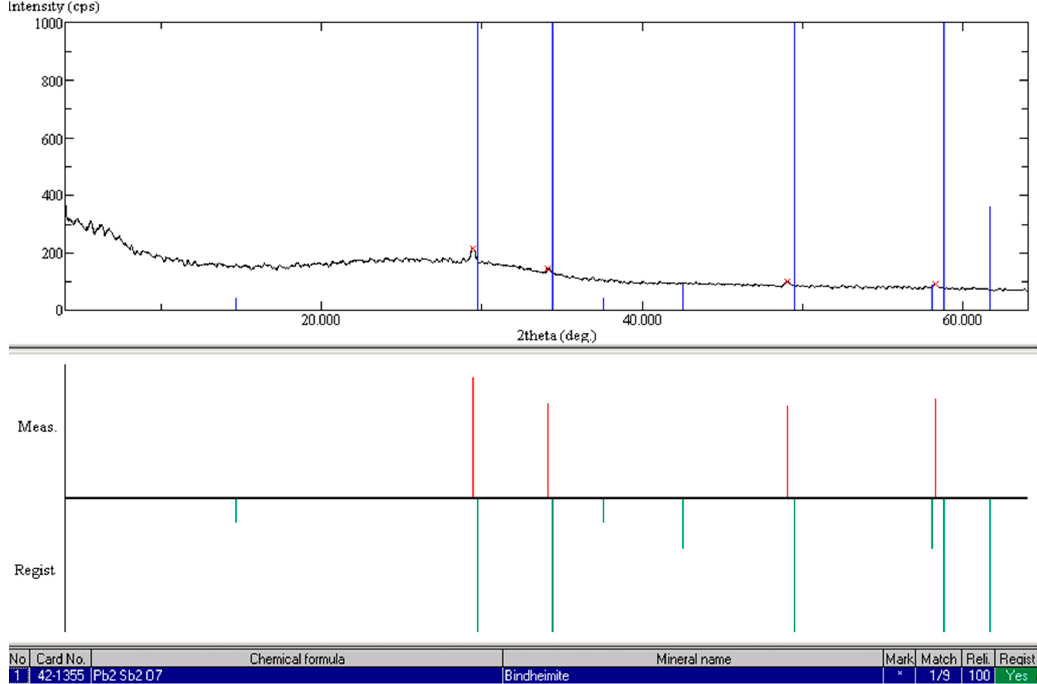
Figure 13. X-ray diffraction pattern of yellow glass containing lead-antimonate, consistent with bindhemite, Figure 13. X-ray di ff raction pattern of yellow glass containing lead-antimonate, consistent with cubic pyrochlore Pb 2 Sb 2 O 7 (SSV_Y1 yellow sample from the monastery of San Severo in Classe, Ravenna, Italy— bindhemite, cubic pyrochlore Pb 2 Sb 2 O 7 (SSV_Y1 yellow sample from the monastery of San